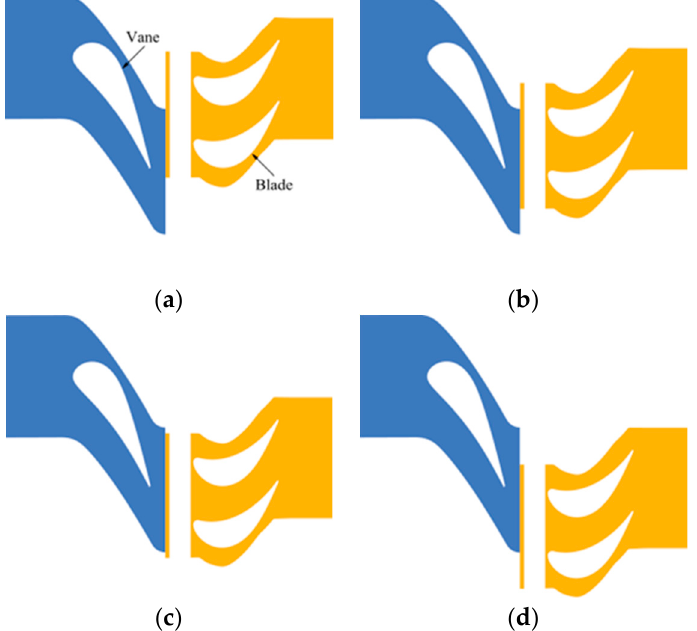
Figure 9. Relative locations of the blades and vane at different times: ( a ) (74 + 1/4) T ; ( b ) (74 + 1/2) T ; ( c ) (74 + 3/4) T ; ( d ) (74 + 1) T .